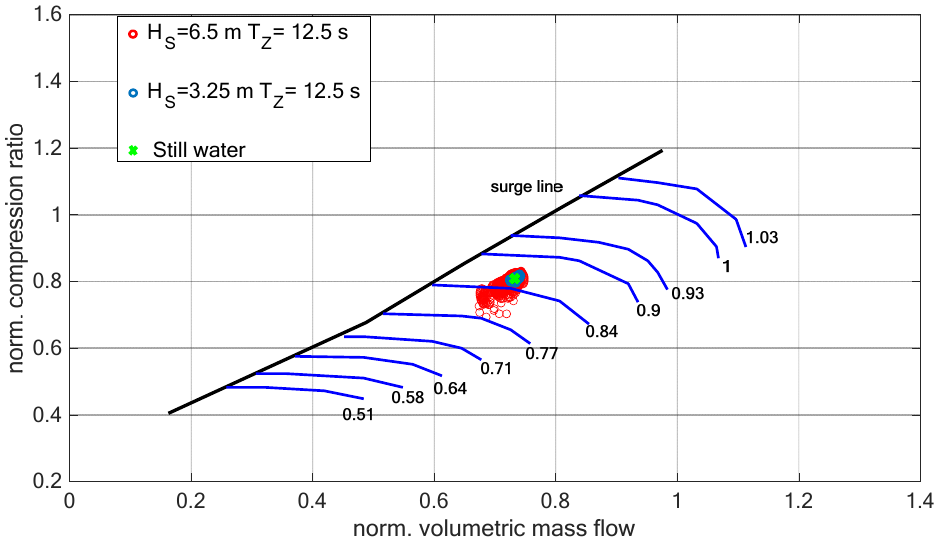
Figure 5. Comparison of compressor performances in a head sea, for two proportional irregular sea states and still water. Surge line in black, compression ratio at constant revolutions in